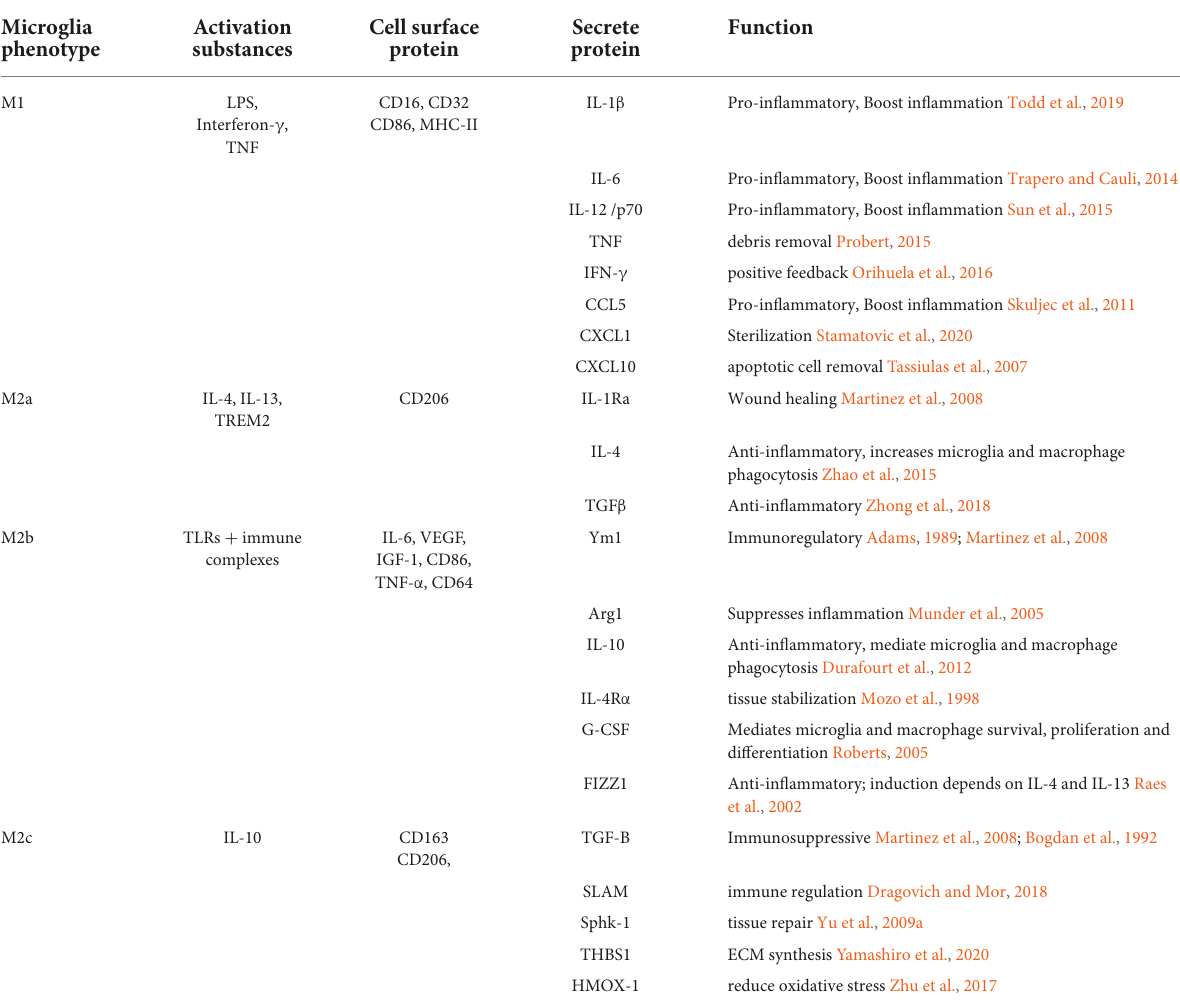
TABLE 1 The characteristics of the different sub-types of